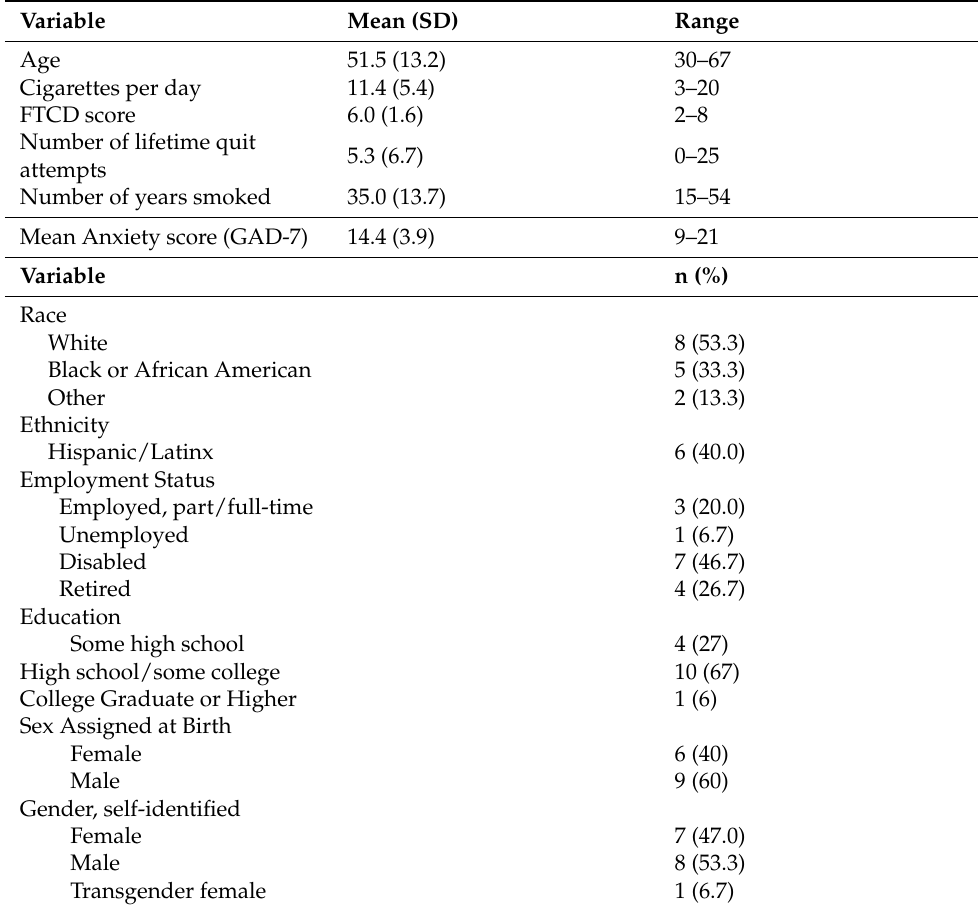
Table 1. Sample characteristics at baseline (n =